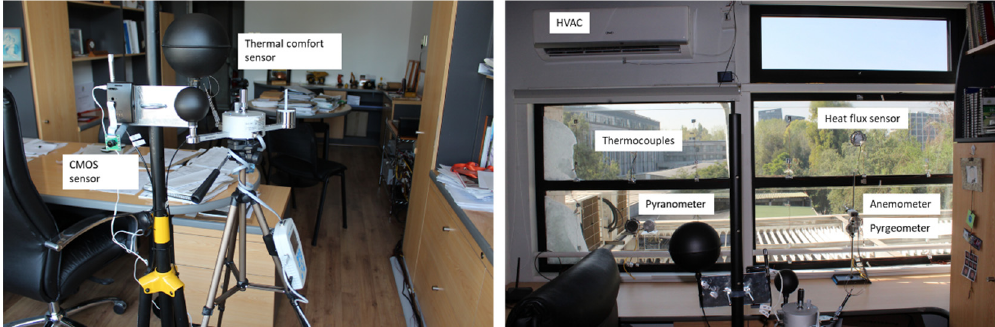
Figure 5. Pictures of the experimental setup. Table 5. List of sensors for each room.